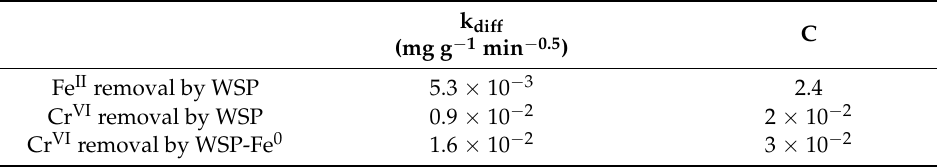
Table 2. Weber and Morris diffusion model parameters.